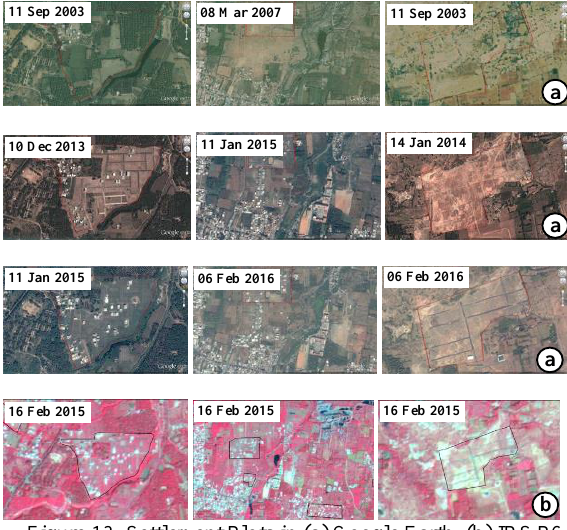
Figure 13: Settlement Plots in (a) Google Earth, (b) IRS P6 LISS – IV